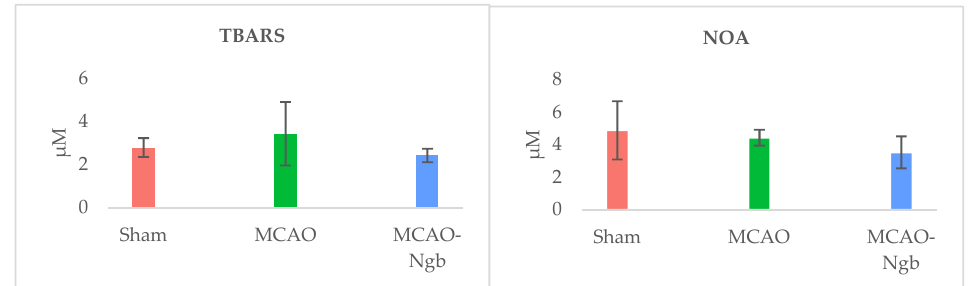
Figure 8. Determinations of oxidative (TBARS) and nitrosative (NOA) stresses in sham, MCAO, and MCAO-Ngb animals. Data are average values of five experimental animals in each group. No significative differences are found.